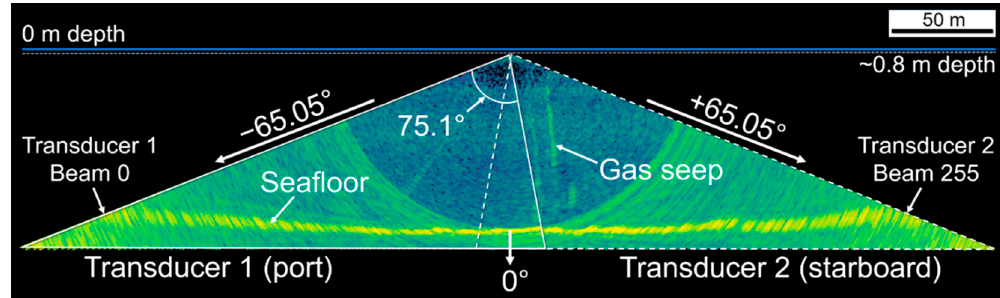
Figure 3. The geometry of the EM2040CD transducer swaths and an example of a gas seep and the seafloor (see Figure 4 for color scale).